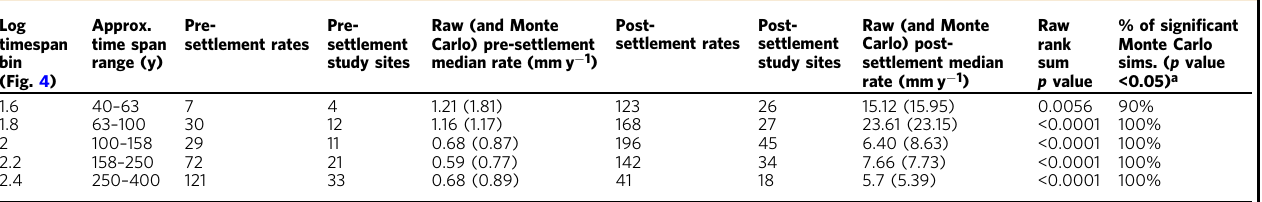
Table 1 Key statistics of pre-settlement (age > 200 y) and post-settlement (age < 200 y) alluvium accumulation rates at timespans between ~40 and 400 y (see also Fig. 4).